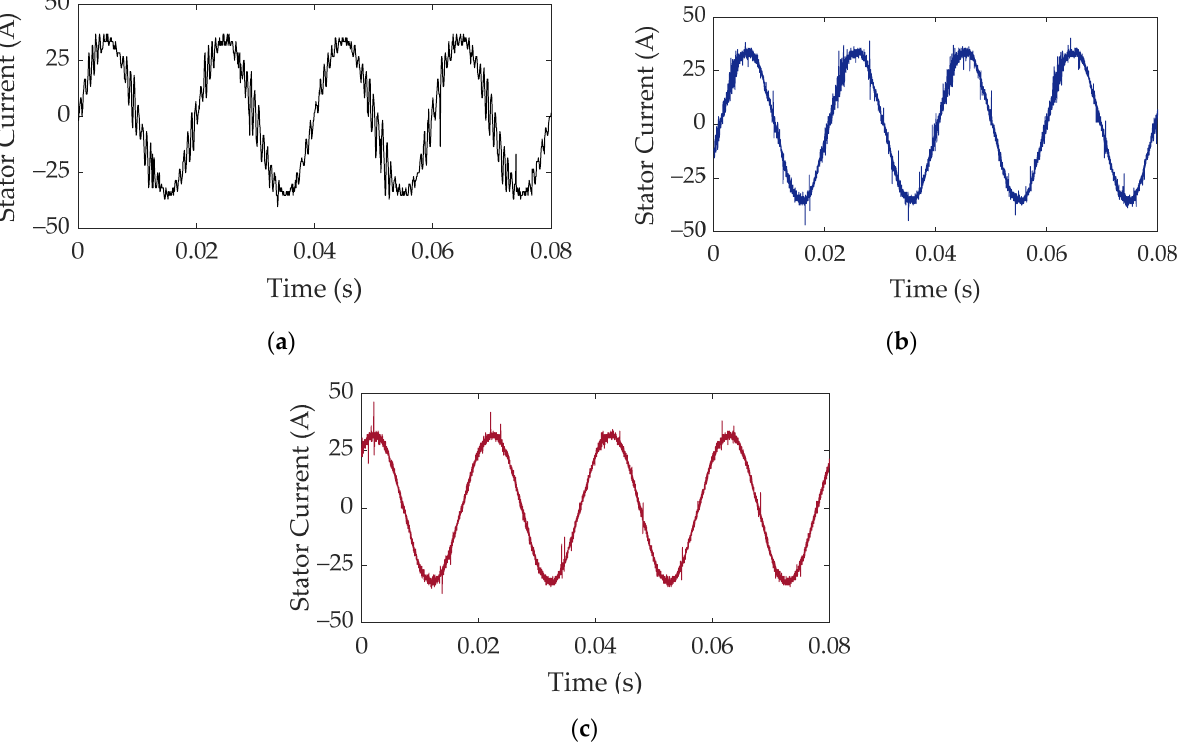
Figure 11. Stator current of the a -phase at a steady-state speed of 1500 r·min − 1 with a 10 N·m load for the ( a ) TDTC, ( b ) CMPTC, and ( c ) proposed MPTC methods.